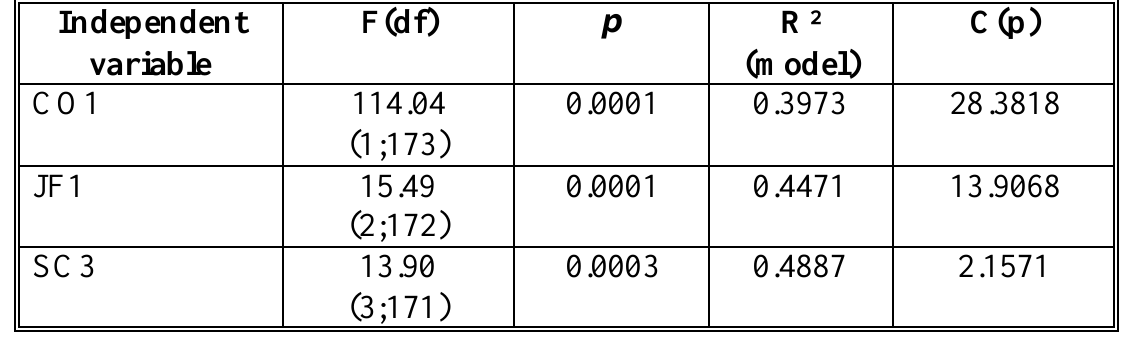
Table 14 Dependent variable: Entrepreneurial attitude total